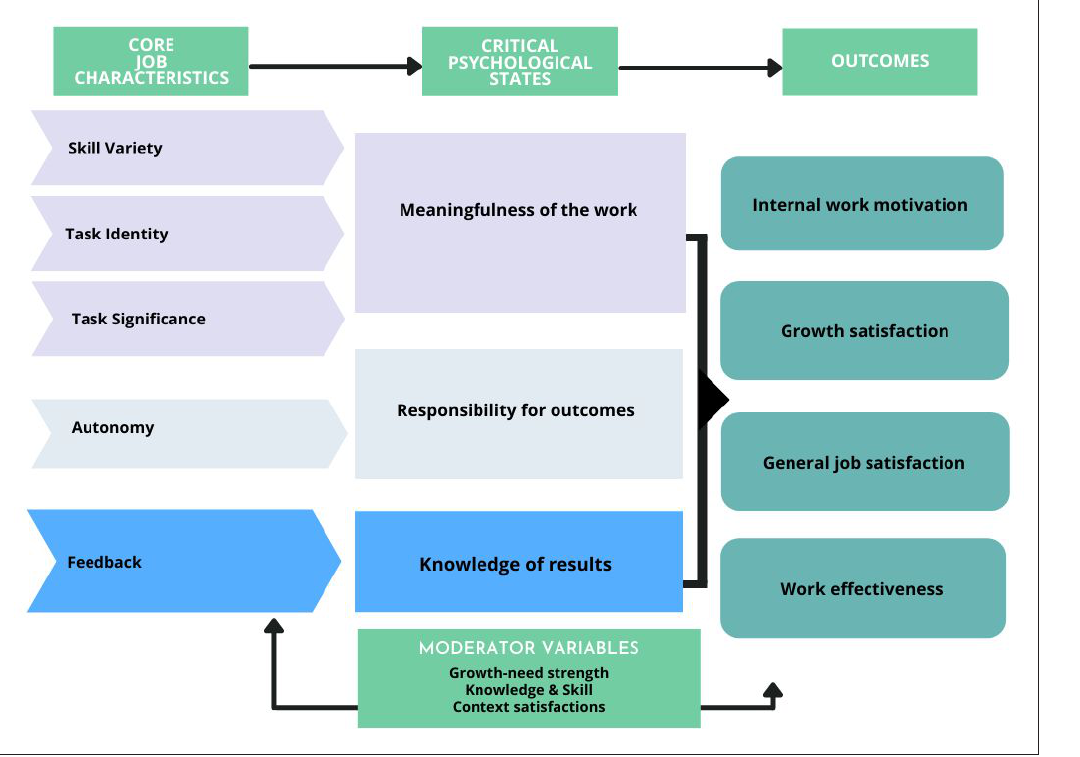
Figure 1 The Job Characteristics